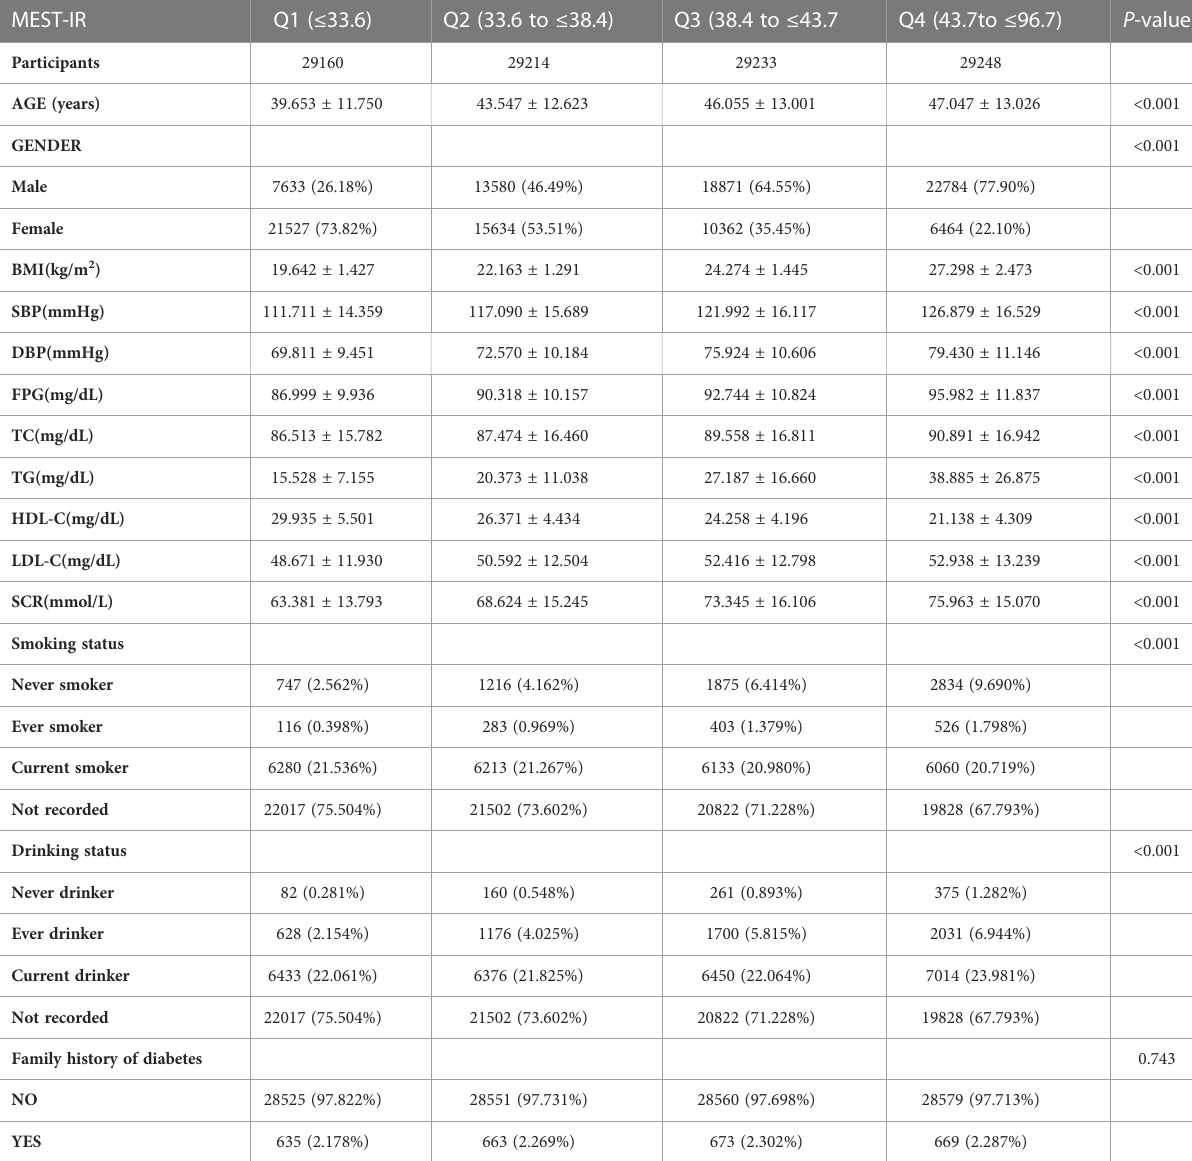
TABLE 1 The Baseline Characteristics of